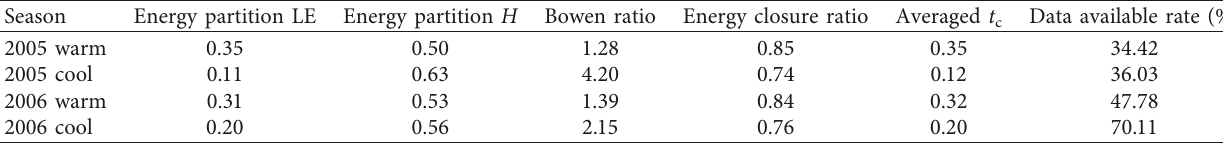
Table 1: Summary of energy partition for LE and H Bowen ratio, energy closure ratio, direct energy transfer coefficient, and data available rate.